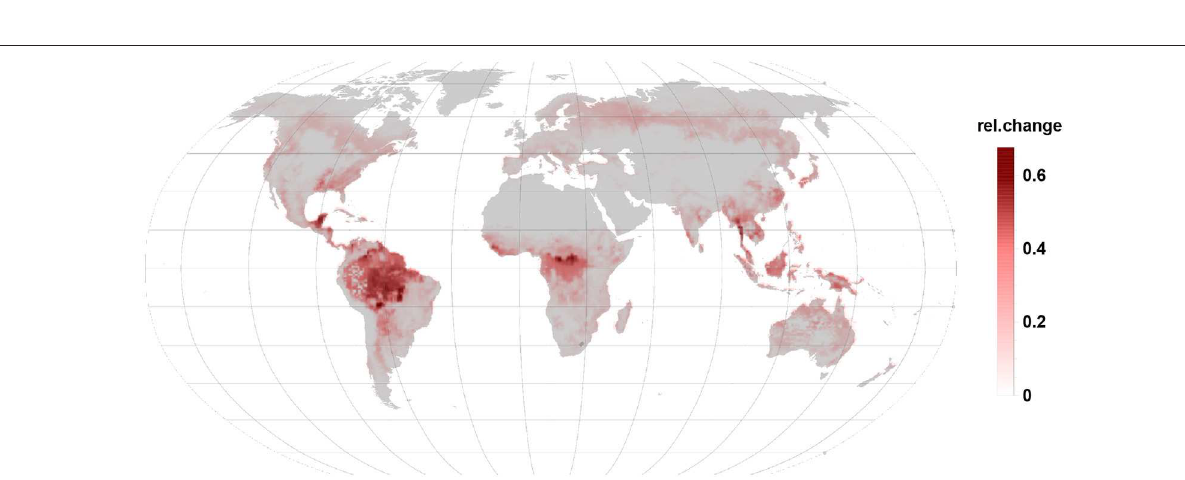
emissions. Given that, gall infection of tree species has effects